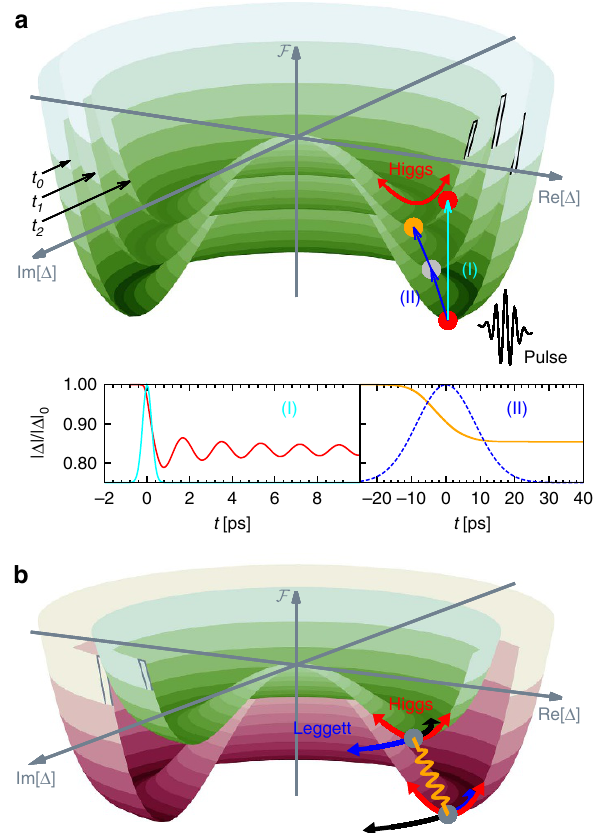
Figure 1 | Illustration of Leggett and Higgs modes. ( a ) Illustration of the excitation process for a one band superconductor. The pump laser pulse modifies the free energy F on different time scales depending on the pulse duration t . For t c h /(2| D |) the superconductor can follow the change in F adiabatically, resulting in a monotonic lowering of the order parameter | D | (orange trace in inset (II)). For short pulses with t t h /(2| D |), on the other hand, the superconductor is excited in a non-adiabatic manner, which results in oscillations of | D | about the new minimum of F (red trace in inset (I)). The blue and cyan lines in the two insets represent the Gaussian profiles of the pump pulses. ( b ) Effective free-energy landscape F for a two-gap superconductor, with green and red representing the Mexican-hat potentials of the smaller and larger gaps, respectively. The amplitude Higgs modes and the phase modes are indicated by red and blue/black arrows, respectively. The Leggett mode corresponds to out-of-phase fluctuations of the phase difference between the two